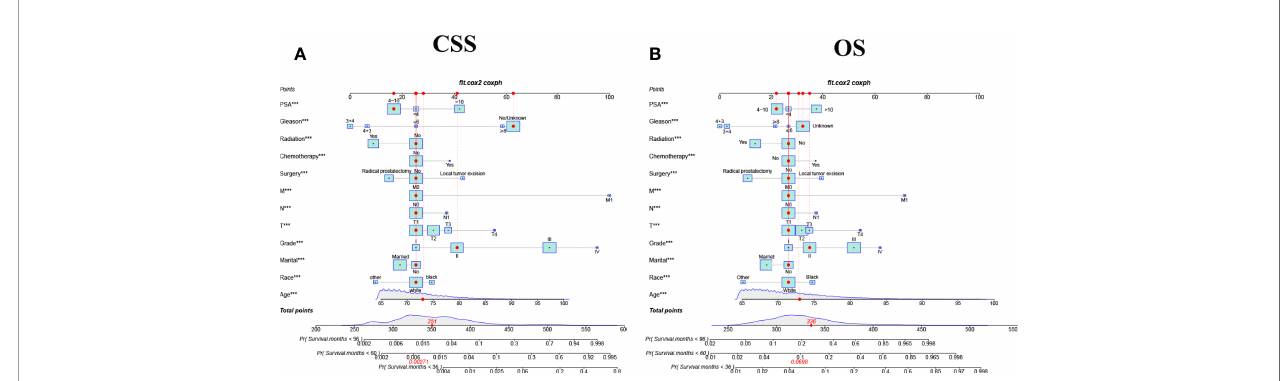
FIGURE 2 | The nomograms for predicting 3-,5-,8-year CSS and OS in elderly patients with PC. (A) The nomogram for predicting CSS in elderly patients with PC. (B) The nomogram for predicting OS in elderly patients with PC. ***P < 0.001 vs. reference.